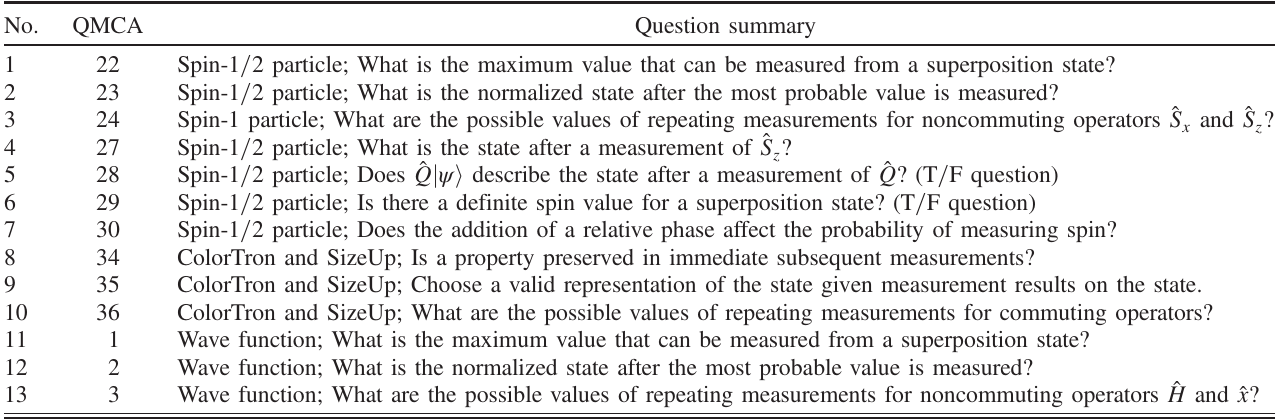
TABLE III. Post-test multiple-choice questions, their corresponding QMCA question numbers, and the conceptual content of each question. The descriptions of the question contents are adapted from Ref.